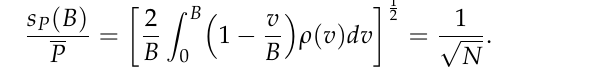
Figure 14. Backscattering coefficient results of rice field Scene 2 after ( a ) spatial and ( b ) frequency averaging at an incidence of 40°.